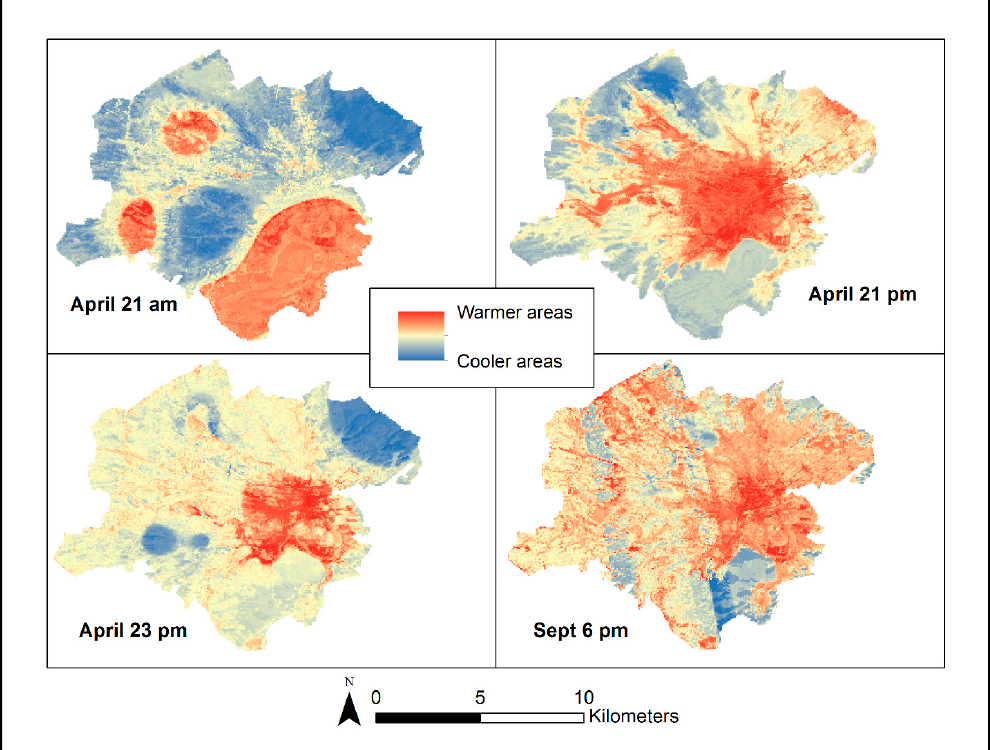
Figure 8. Patterns for estimated air temperatures across the entire City of Roanoke for three time periods in April 2013 and the afternoon of 6 September 2013. Temperature data collected and processed as outlined in